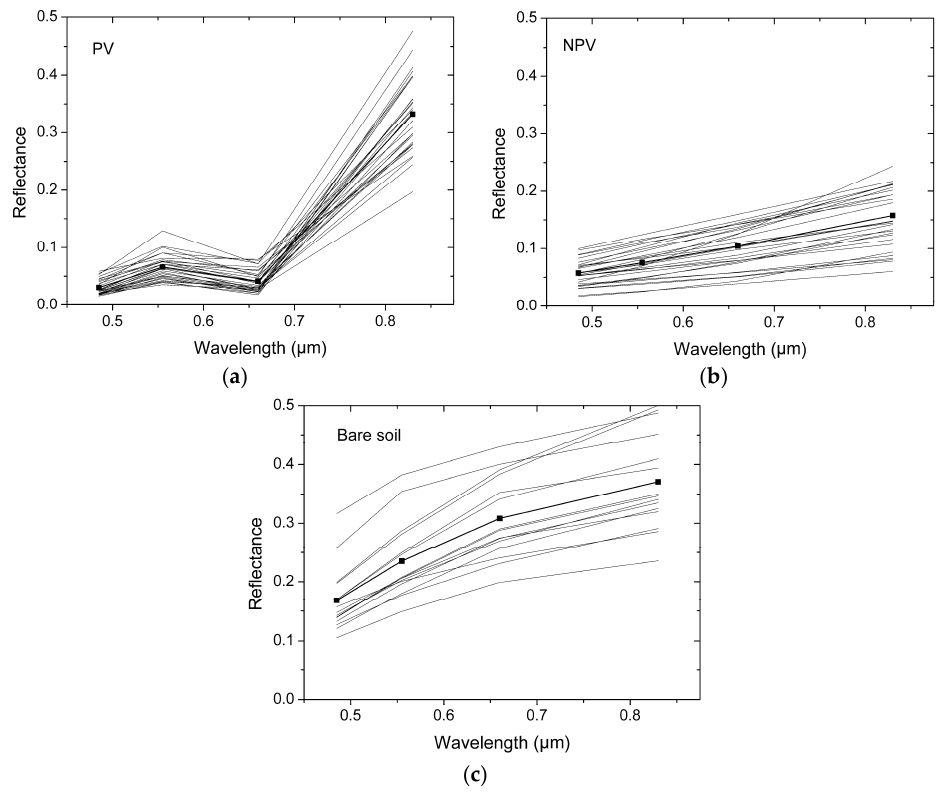
Figure 3. Endmember spectra of ( a ) Photosynthetic vegetation (PV); ( b ) Non-photosynthetic vegetation (NPV) and ( c ) Bare soil used in Spectral Mixture Analysis (SMA), the filled squares are the average values of different types.